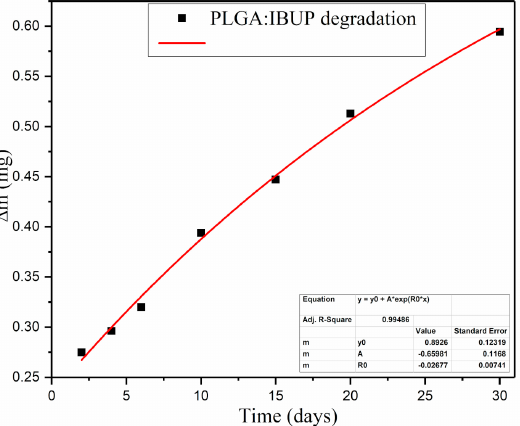
Figure 3. Degradation of PLGA/IBUP coatings during biologically simulated dynamic testing, evidenced by mass loss